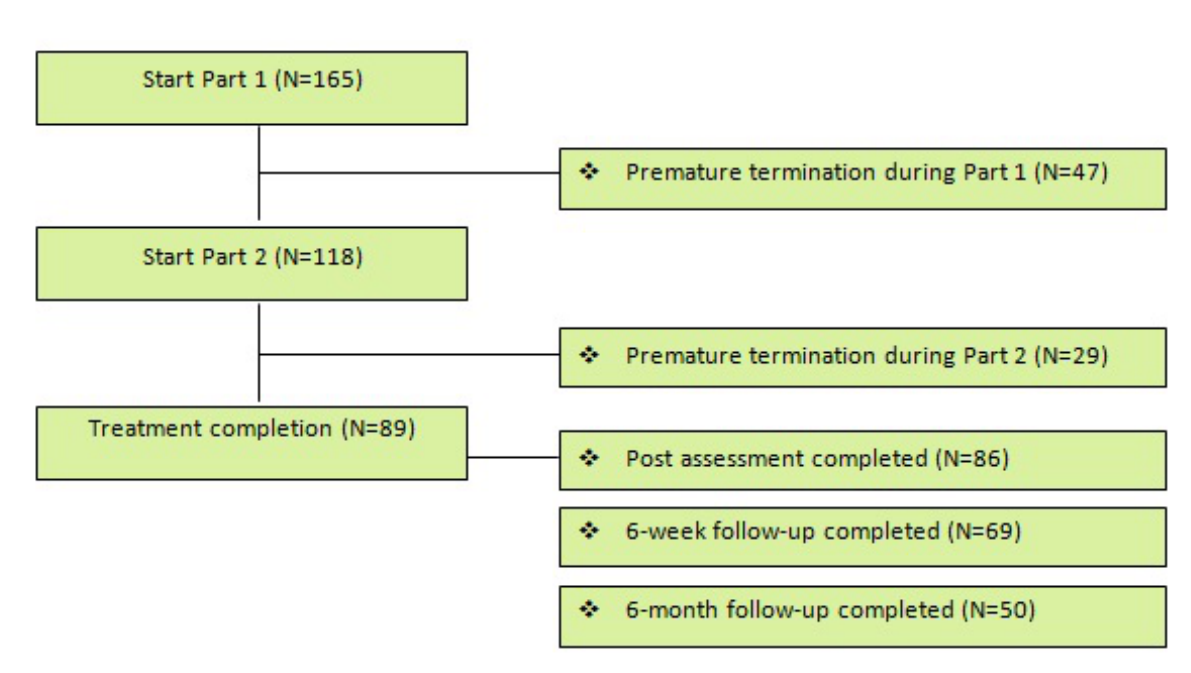
Figure 3. Participant